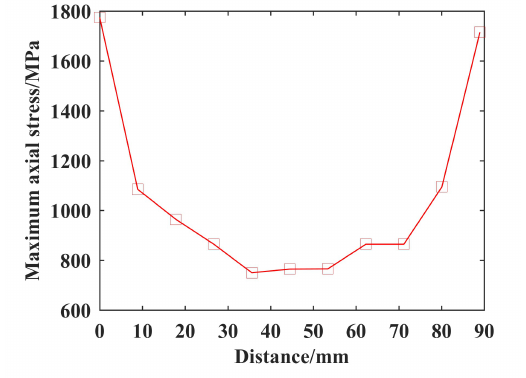
Fig. 12. Maximum stress of different cross sections of the positive